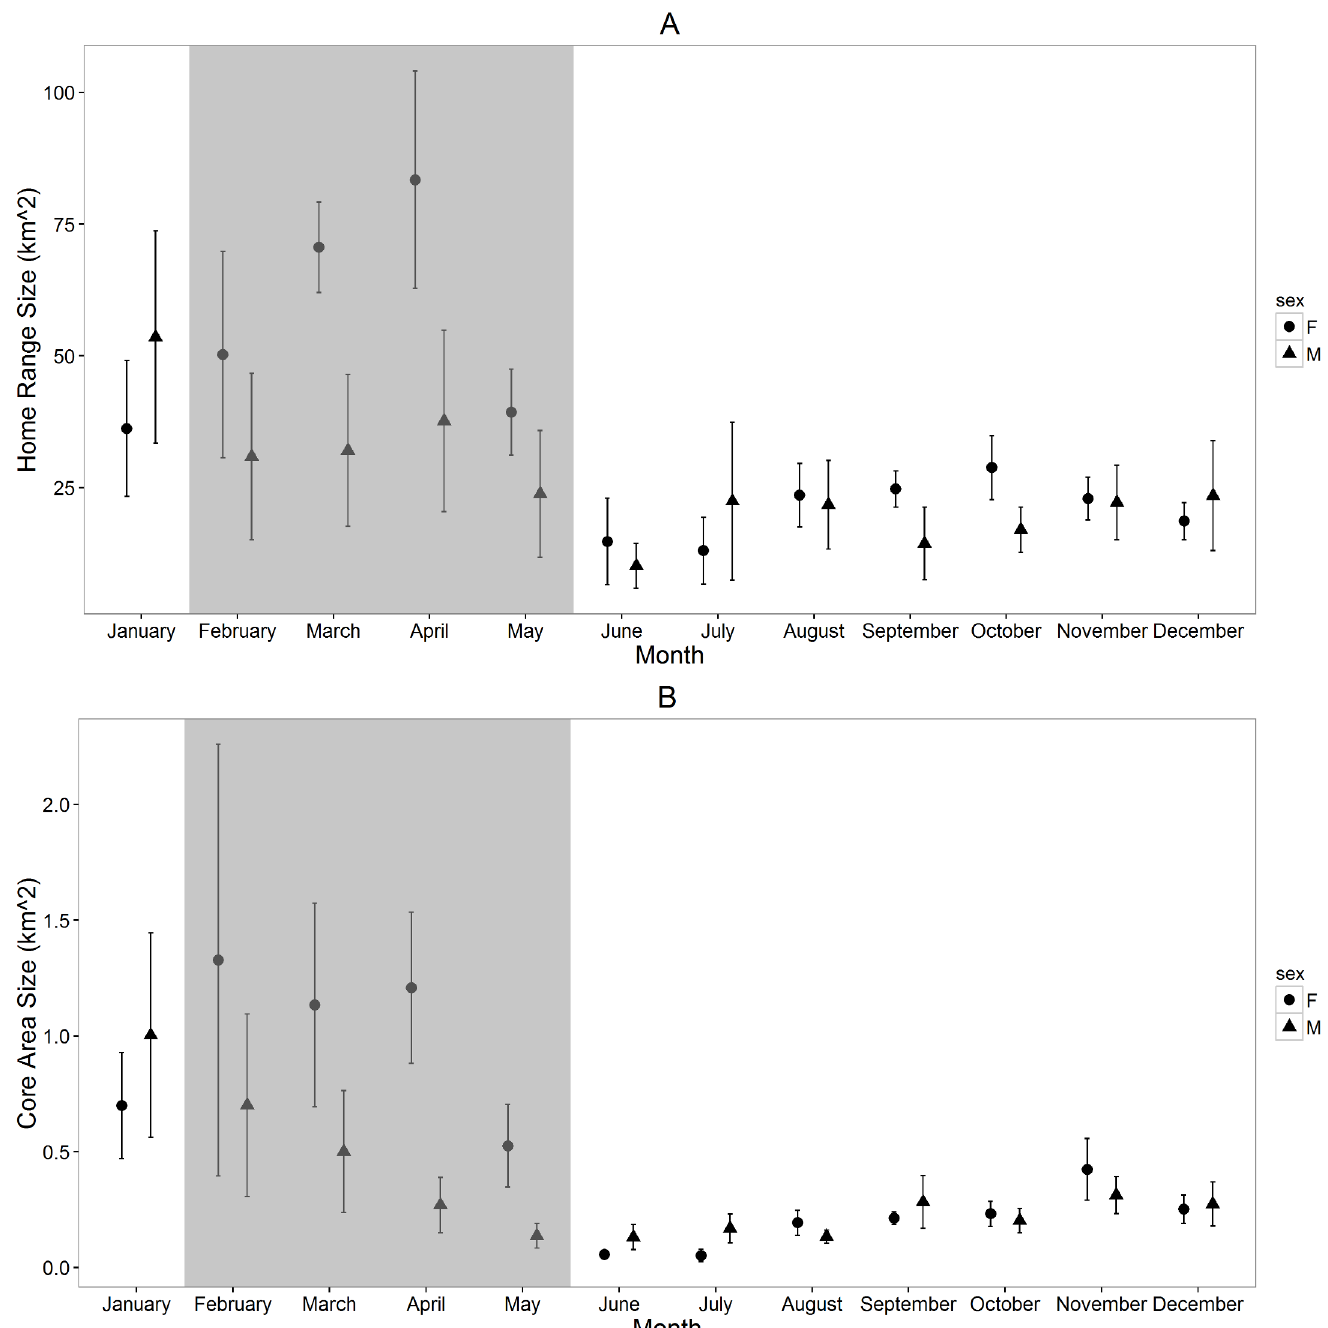
Fig 2. Mean ( ± SE) monthly (A) 95% home range and (B) 50% core area sizes (km 2 ) for 5 male (total locations = 437,629;mean locations/ month = 8,429; range = 3,164–14,391) and 4 female (total locations = 363,210;mean locations/month = 7,753; range = 895–13,340)resident black vultures (BLVU) calculated from GPS locations collected September 1, 2013–August 31, 2015. Shadedregionhighlightsmonths within the